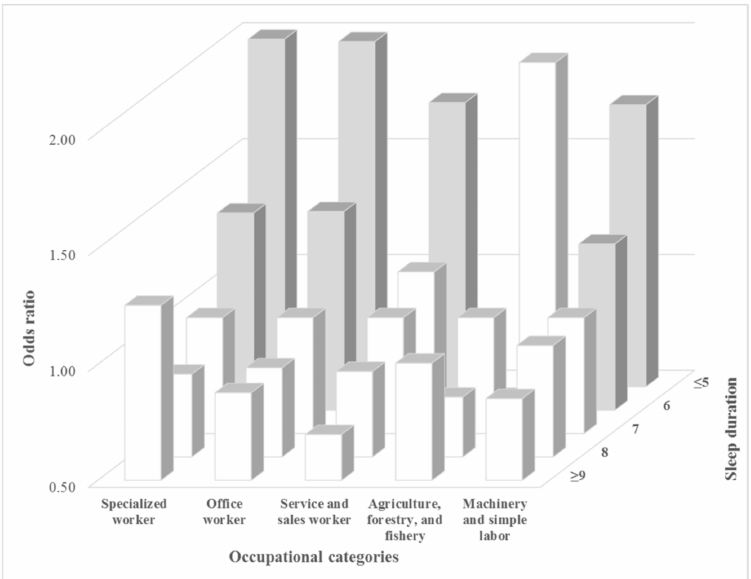
Figure 1. Subgroup analysis results for high-stress awareness according to occupational categories and sleep duration. Gray bar shows that the results of the multiple logistic regression were statistically significant ( p -value < 0.05). Analyses were adjusted for the following covariates: age, educational level, household income, occupational categories, marital status, physical activity, alcohol consumption, smoking status, BMI, perceived health status, depressed mood, and chronic